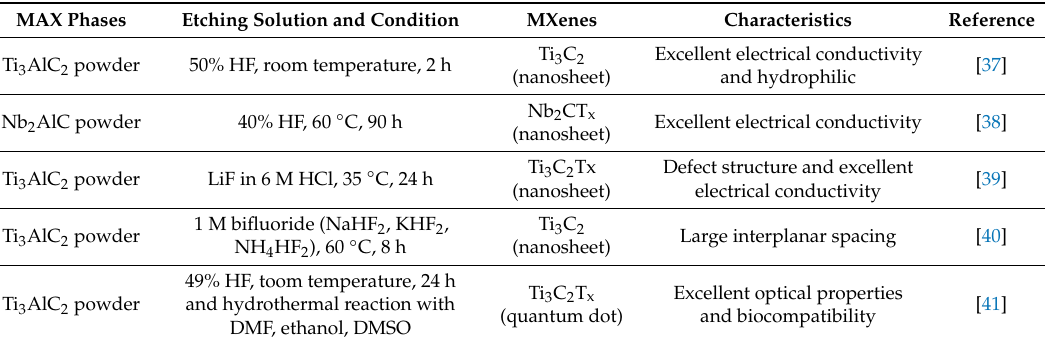
Table 1. Table of the studies for synthesis of MXenes using di ff erent etching